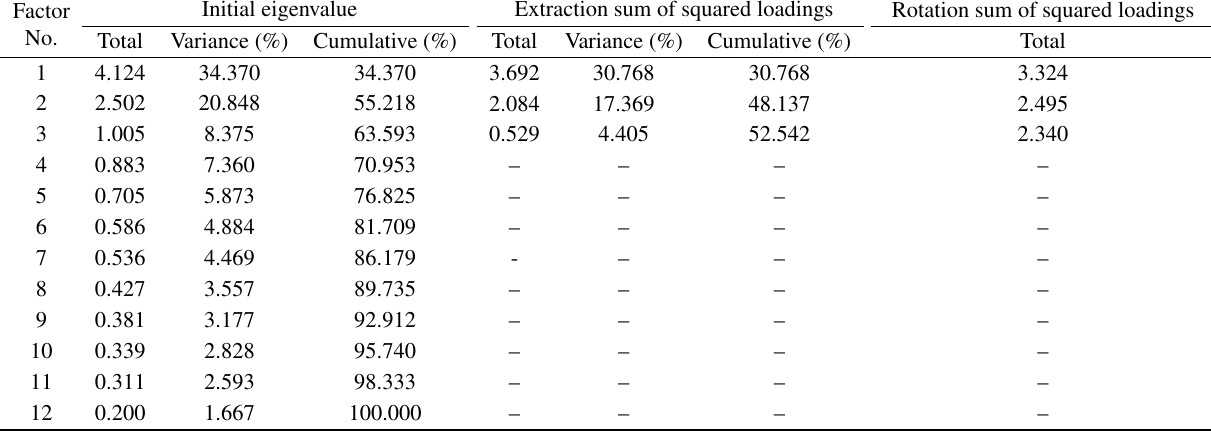
Table 8 Total variance